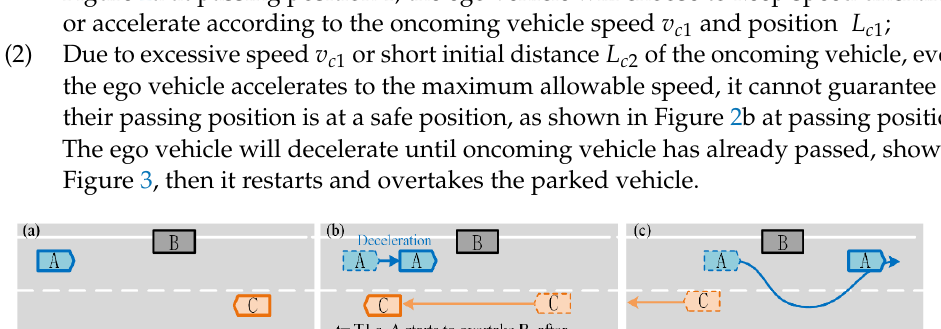
Figure 3. The case of ego vehicle slowing down. ( a ) Relative positions between vehicles at t = 0 s; ( b ) Relative positions between vehicles at t = T1 s; ( c ) Relative positions between vehicles at t = T2 s.